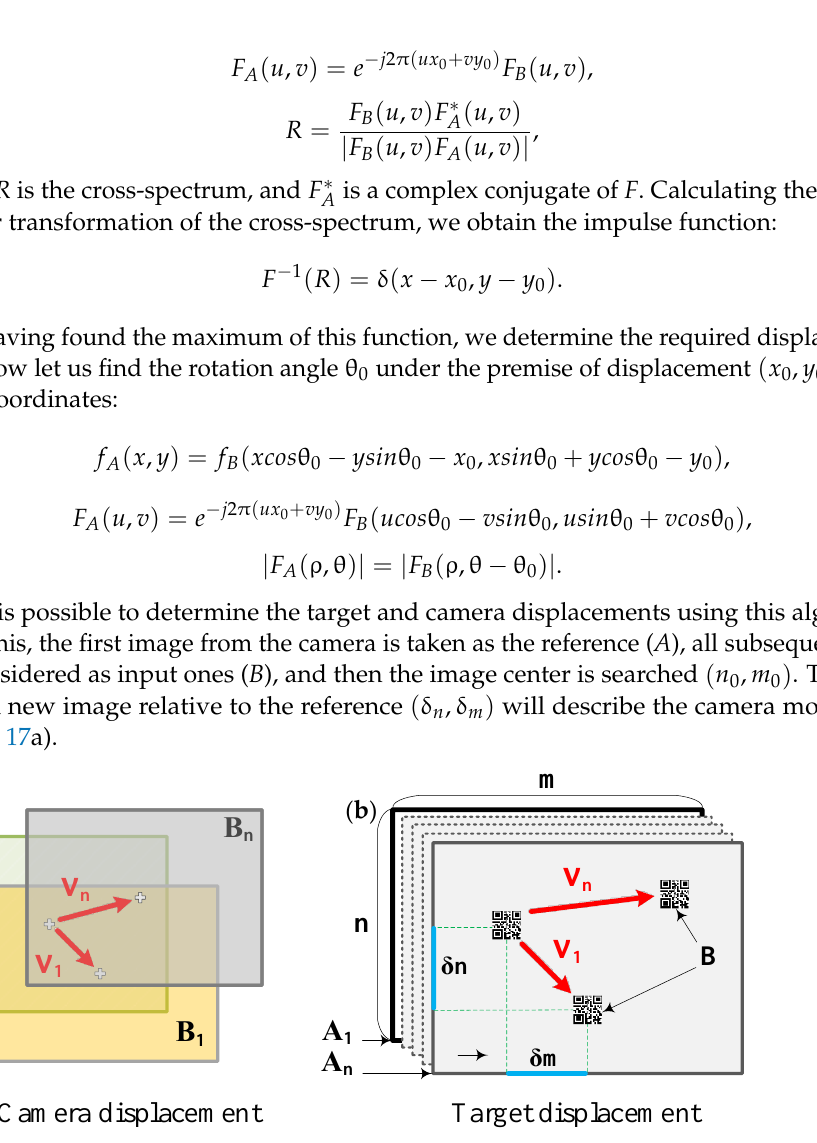
+ δ m 2 ; V n = δ n 2 n + δ m 2 n ): ( a ) for 1 1